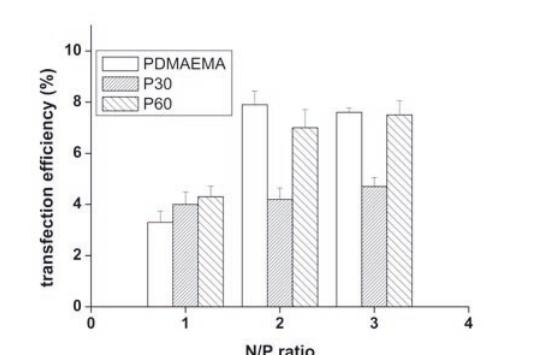
Figure 7. Effects of various polymers on relative SGC-7901 cell viability. The concentration of copolymer is expressed as the concentration of DMAEMA monomer.